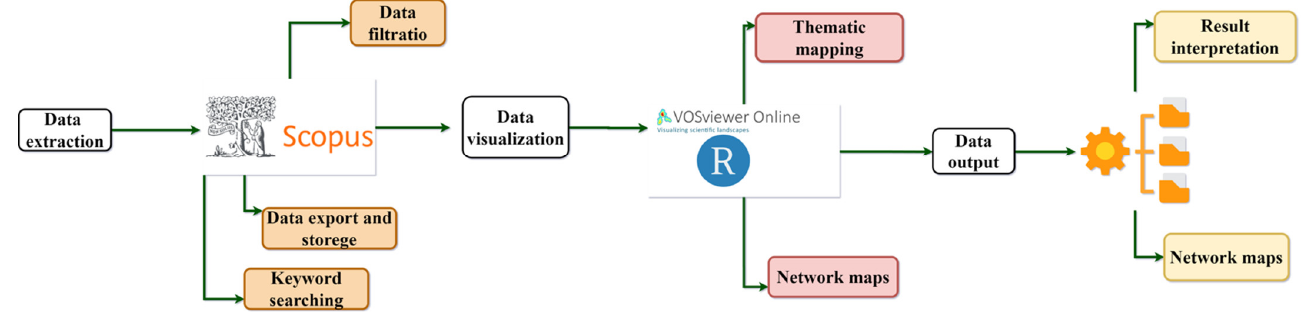
Figure 2. Analysis tools.